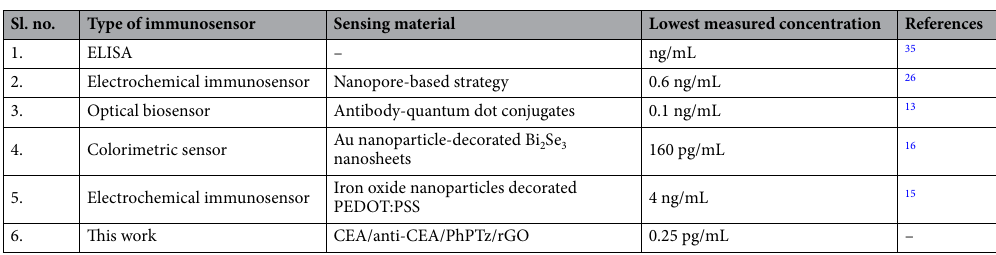
Table 1. Comparison between different biosensors reported for CEA detection and the ones developed in this research.